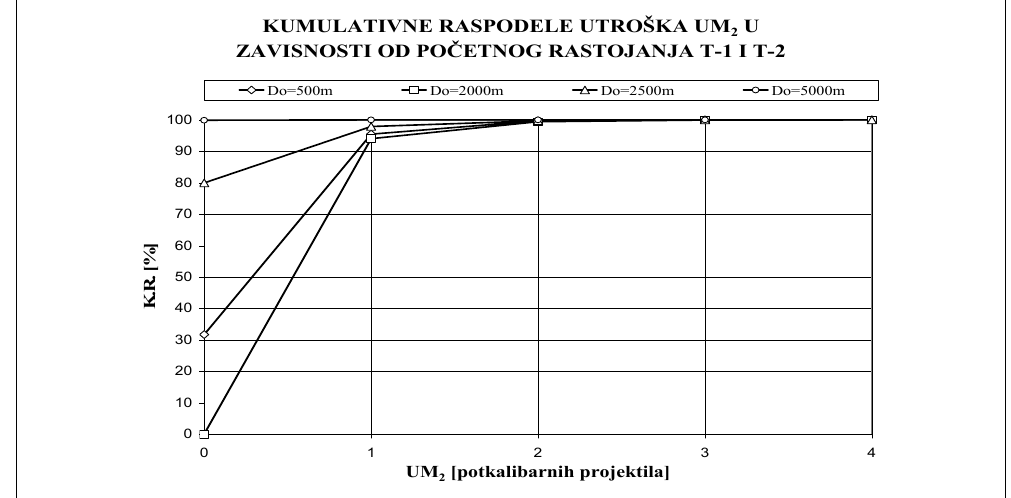
Sl. 9 – Kumulativne raspodele utro{ka potkalibarnih projektila u zavisnosti od po~etnog rastojanja